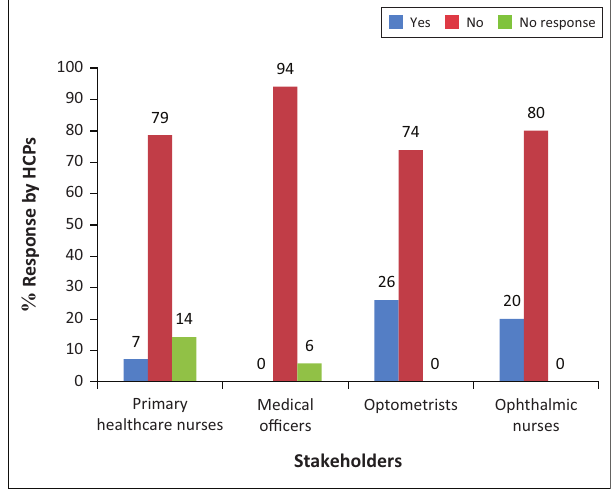
HCPs, healthcare practitioners. FIGURE 7: Percentage of responses by healthcare practitioners to modify diabetic retinopathy screening